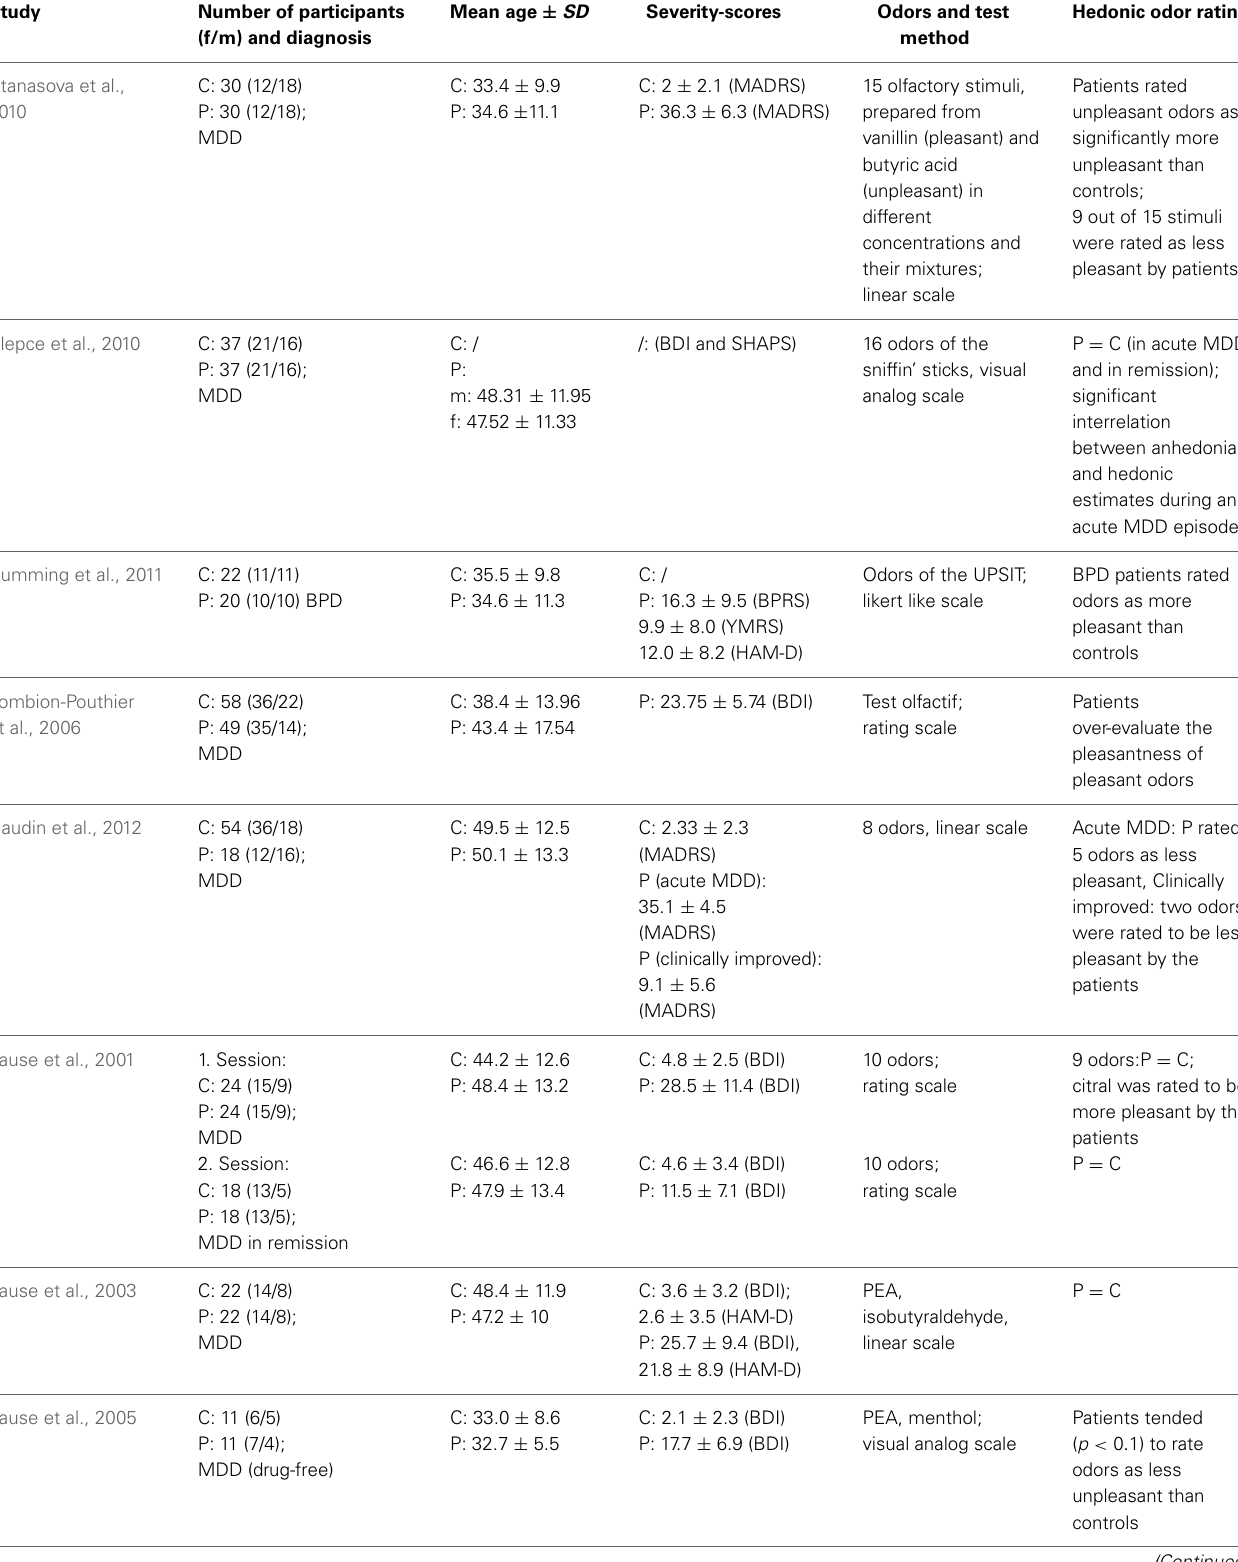
Table 5 | Summary of studies of hedonic odor ratings in affective